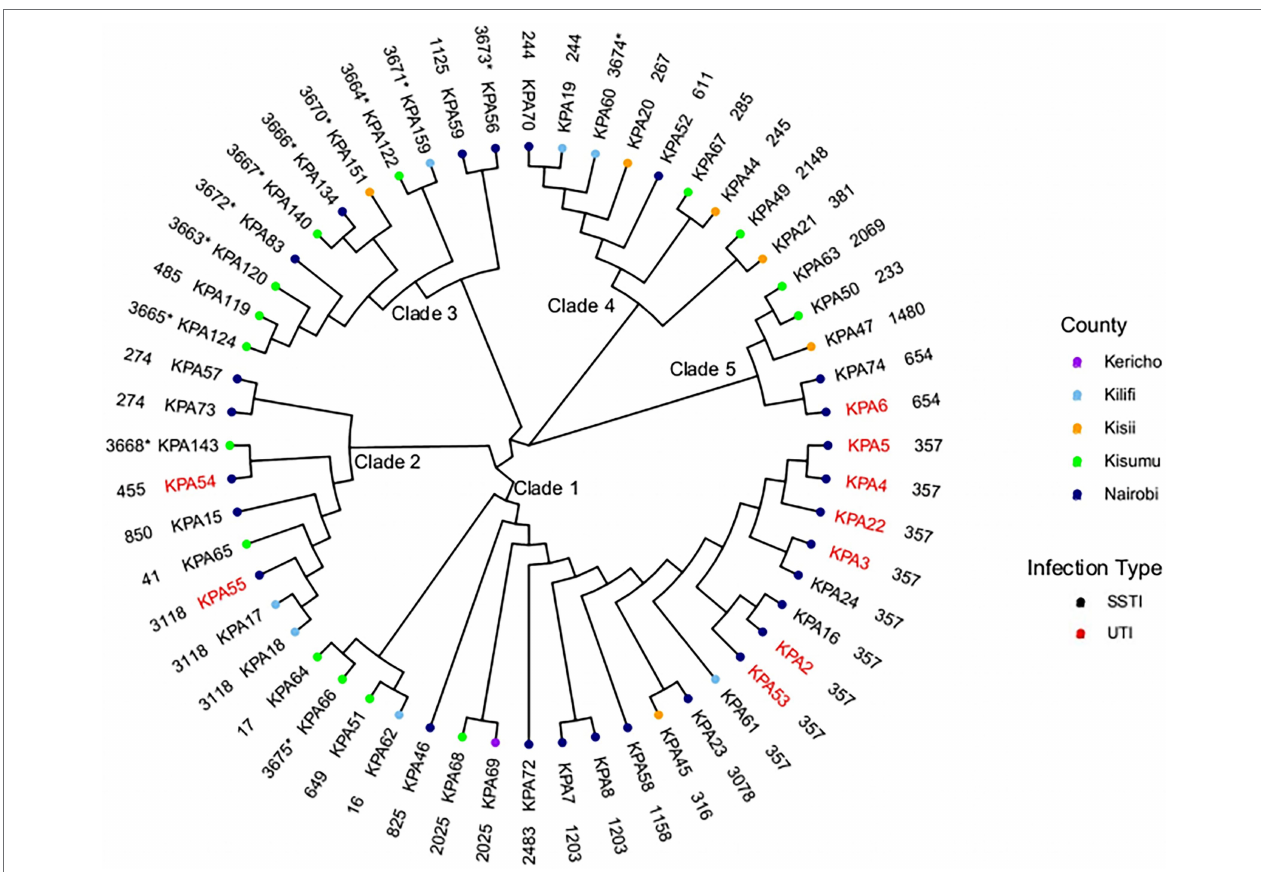
TABLE 1 | Allelic profiles of novel Pseudomonas aeruginosa multilocus sequence types (MLST). Sequence Isolates types